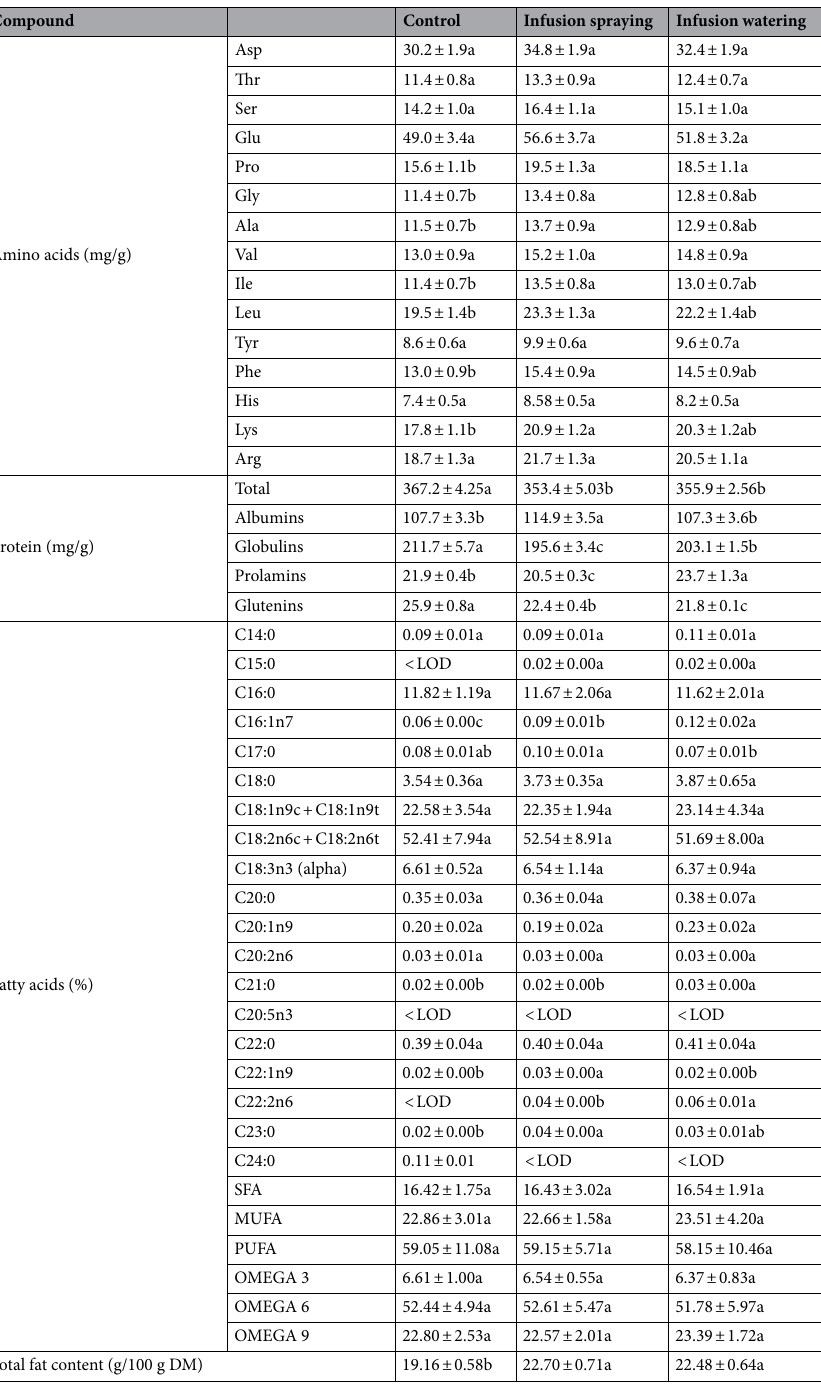
Table 6. Effect of soybean treatment with extracts from Levisticum officinale on the protein content, its amino acid profile and fatty acid composition (means of 2018–2020 ± SD). Means in the rows, concerning the selected traits, followed by different letters are significantly different at p <